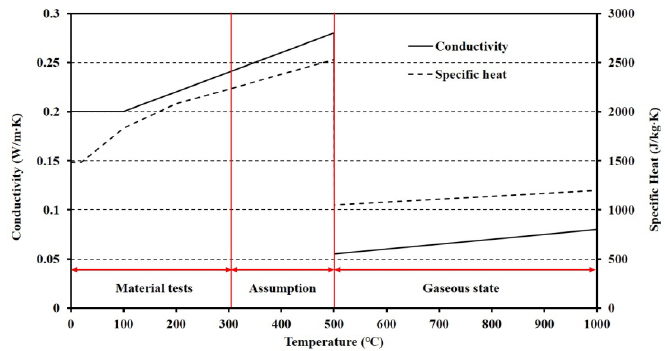
Figure 13. Conductivity and specific heat of polymeric materials at elevated temperatures.